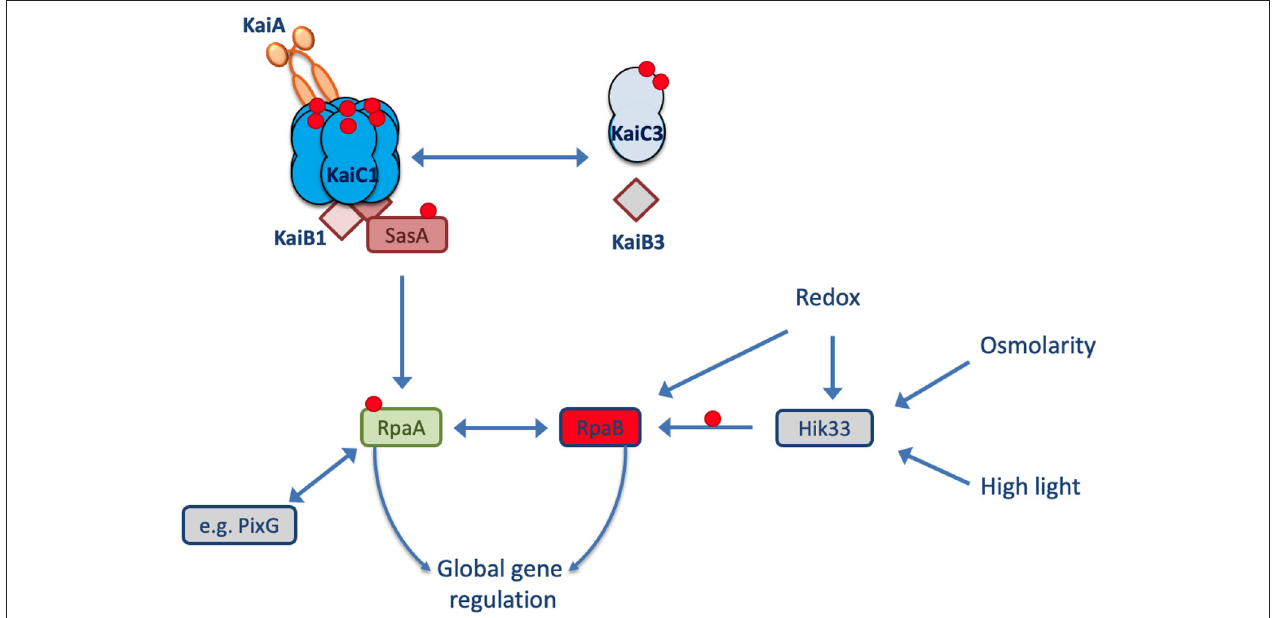
FIGURE 1 | Model of the Synechocystis Kai system. In Synechocystis, the KaiAB1C1 system is the closest homolog to the well-known circadian clock system from Synechococcus elongatus PCC 7942. The output signaling response of KaiC1 relies on the SasA-RpaA two-component system. The transcription factor RpaA controls gene expression in L and D conditions. RpaA can interact with other regulators (e.g., PixG and RpaB) and partially targets the same genes as the transcription factor RpaB. The KaiAB1C1 complex is intertwined with the non-standard KaiB3C3 system in Synechocystis, but the direction of signaling between the two systems remains unclear. The red circles represent phosphorylation